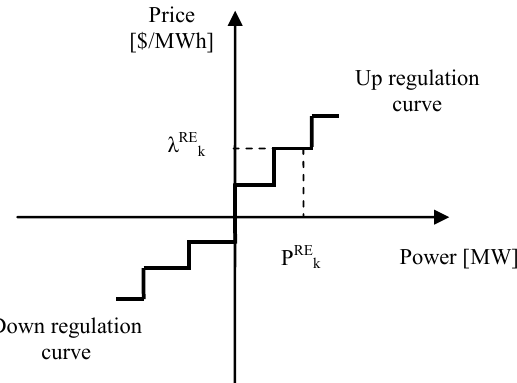
Figure 2. Up/down regulation prices in real-time